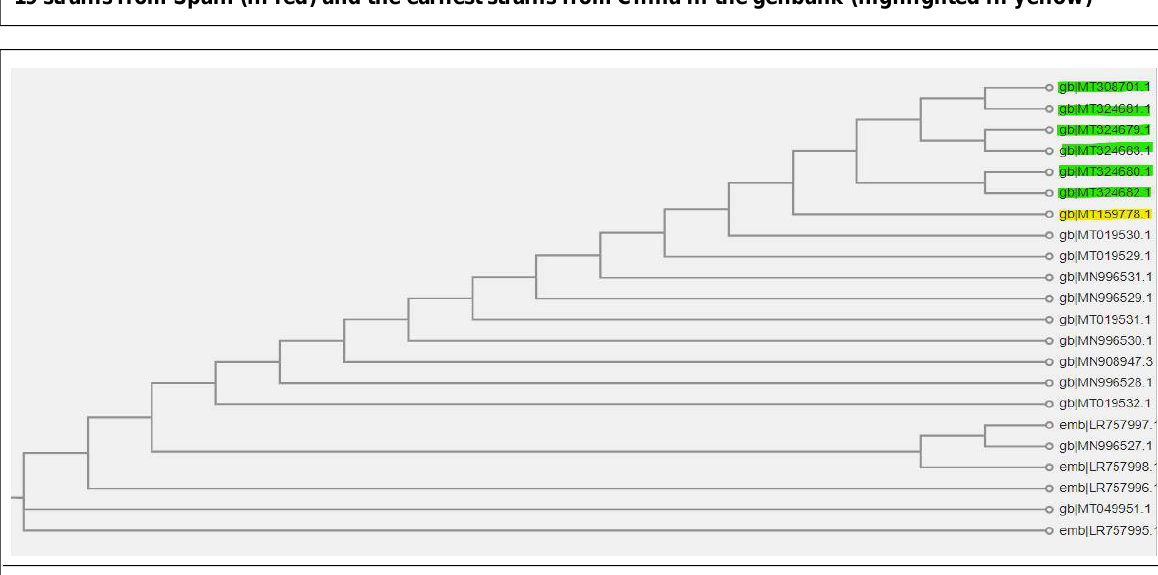
Figure 3: A Phylogenetic tree showing the COVID-19 strains from Africa (Nigeria-MT 159778- in yellow and Tunisia- in green (MT 308701, MT 324681, MT 324679, MT 324683, MT 324680, MT 324682) and their relationship to the first strains from